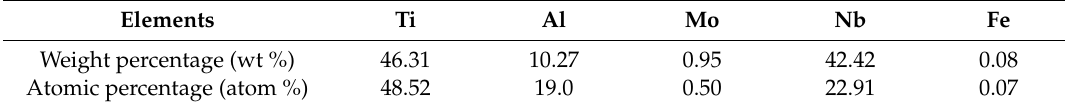
Table 1. Measured chemical composition of the Ti 2 AlNb